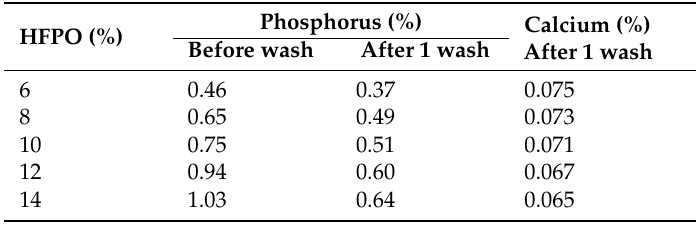
Table 3. The phosphorus and calcium concentrations of the Nomex ® /cotton blend fabric treated with 3% BTCA and HFPO at different concentration and cured at 170 °C for 3 min.